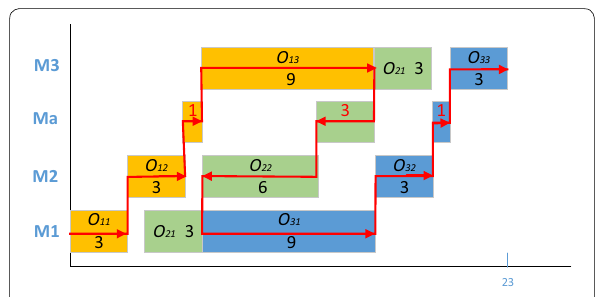
Figure 10 The critical path in the Gantt chart of NWFSP